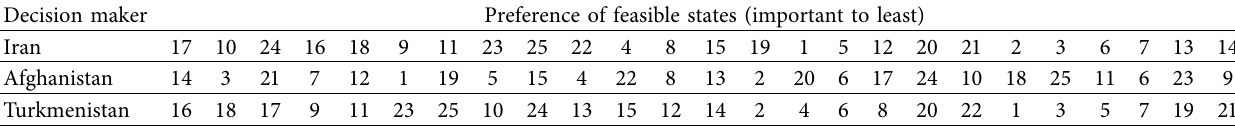
Table 5: Decision makers preference of feasible